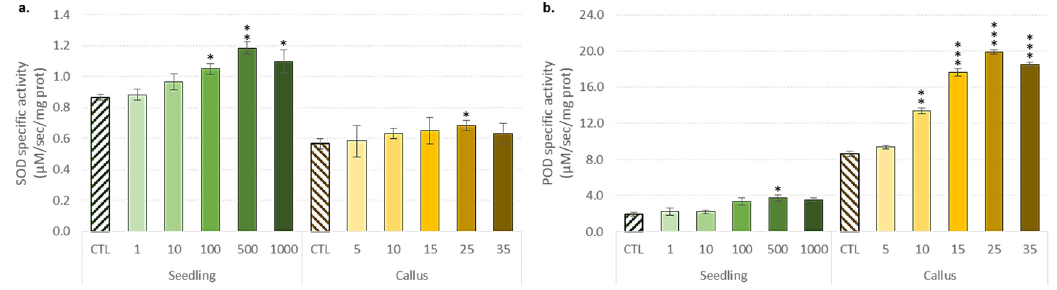
Figure 3. Effect of the different concentrations of ZnONPs on the antioxidant enzymes. ( a ) The superoxide dismutase activity (SOD) and ( b ) the peroxidase activity (POD) in the seedlings and the stem-derived callus of L. usitatissimum . Values are means ± SD of three independent experiments; * p < 0.05, ** p < 0.01, *** p < 0.001.